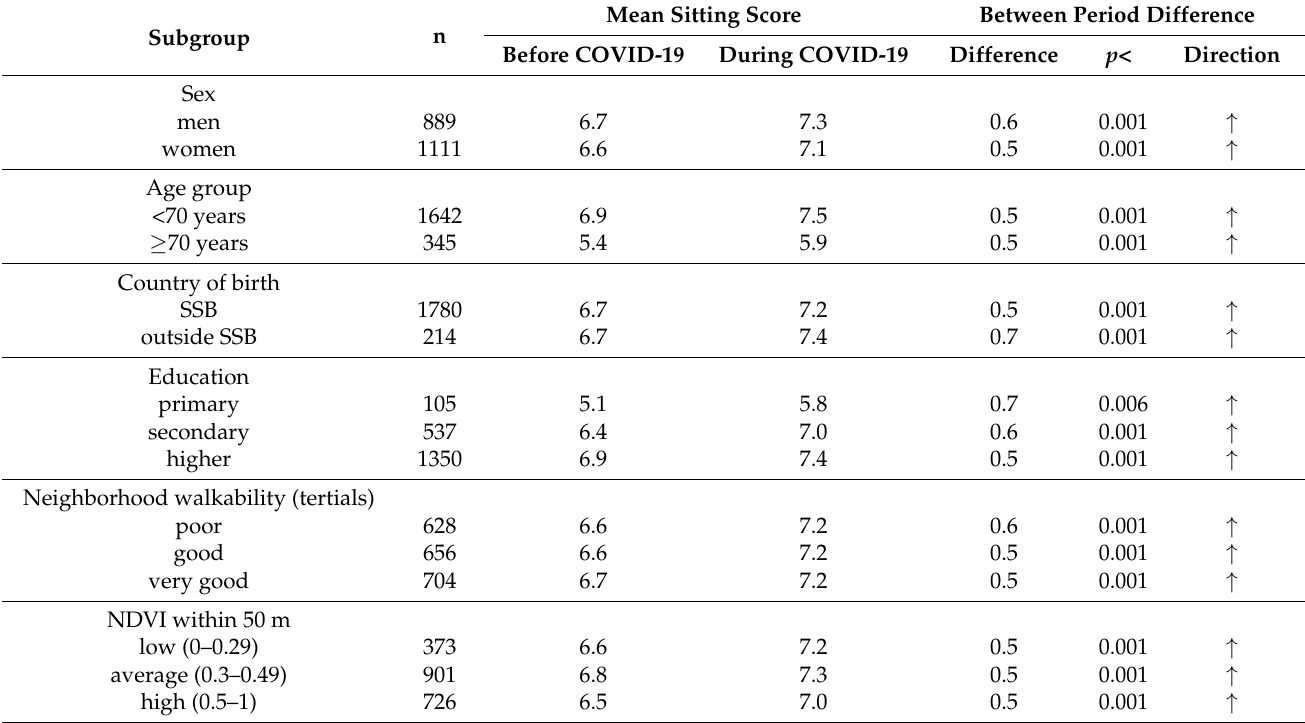
Table 6. The average weekly sitting